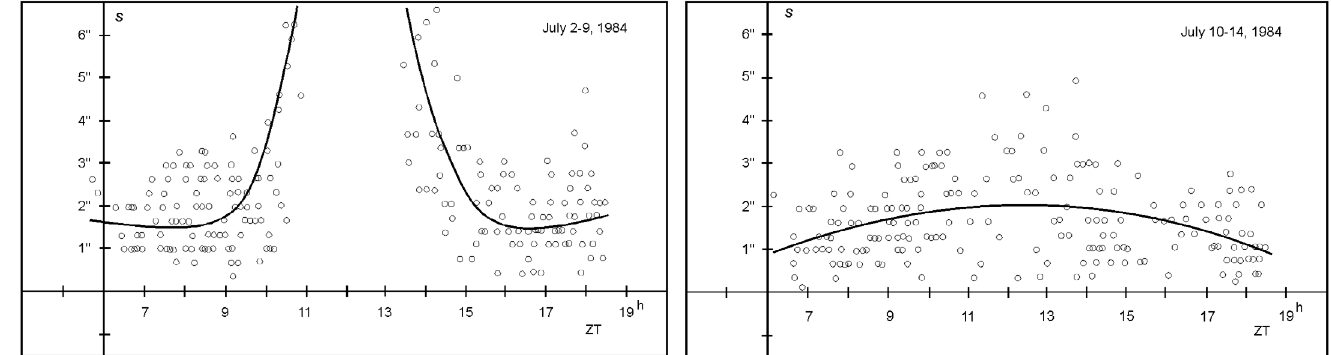
Figure 6. Daily changes of the standard deviations from individual sets of the Sun observations using the zenith-distance (left) and hour-angle method (right). (LTST = Local True Solar Time) [Solari ć and Špoljari ć